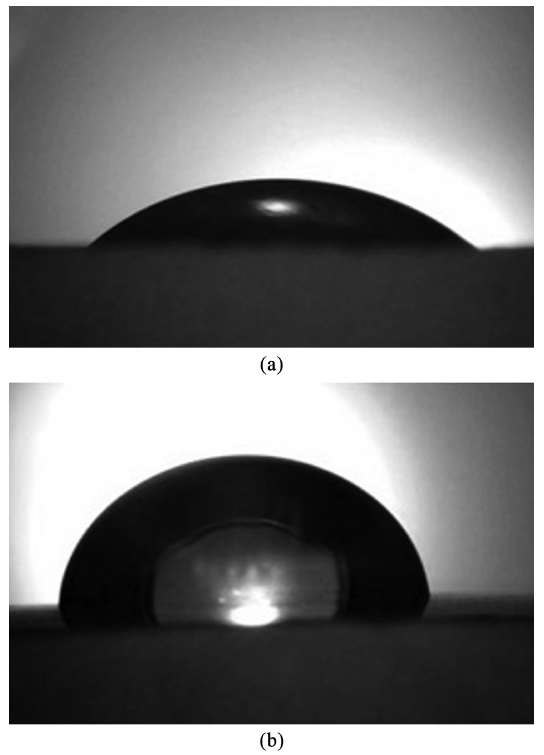
Figure 4. Image of the insulator sample for calculating the contact angle by the addition of a water droplet on the surface using a goniometer. (a) Sample without deposition. (b) Sample with deposition.